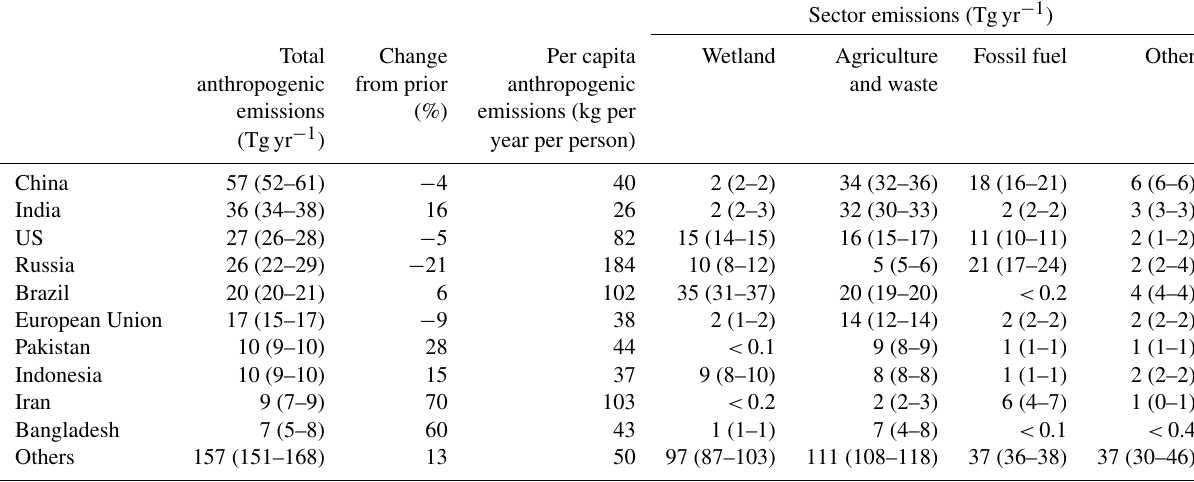
Table 2. Top 10 contributors to global anthropogenic methane emissions. 1 ,